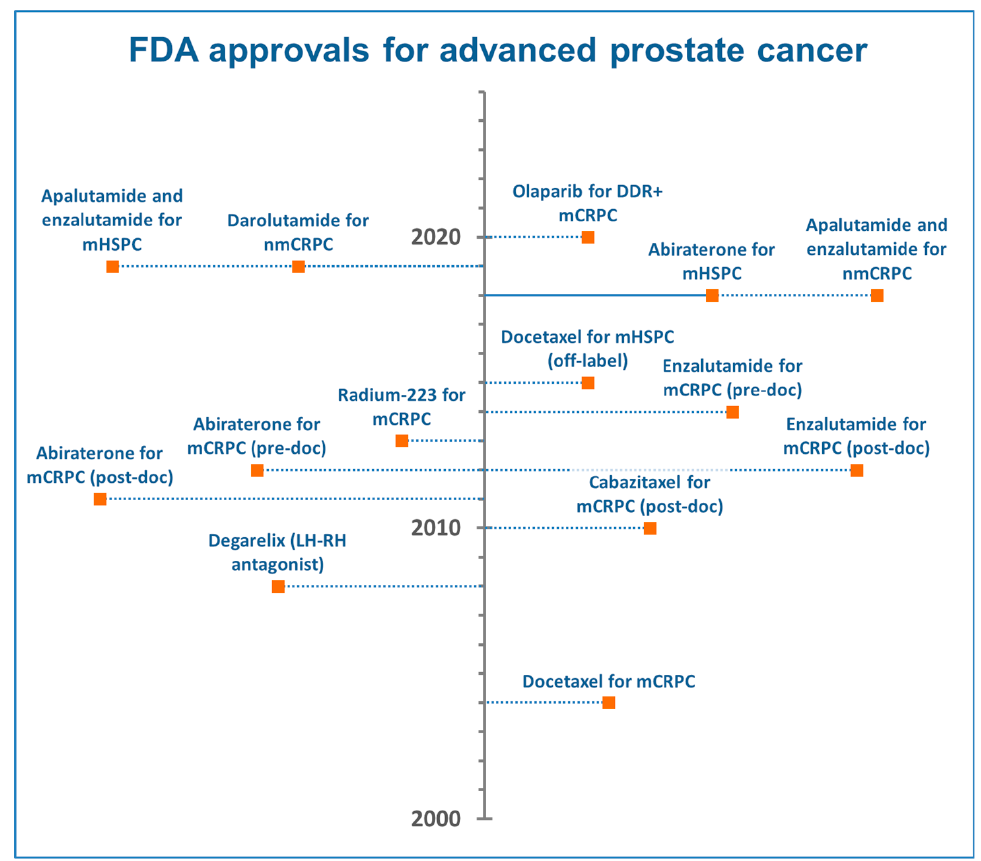
Figure 1. Regulatory timeline of approvals in advanced prostate cancer therapies. DDR+: DNA damage response genes mutated; mHSPC: metastatic hormone-sensitive prostate cancer; mCRPC: metastatic castration-resistant prostate cancer; nmCRPC: nonmetastatic castration-resistant prostate cancer; post-doc: post-docetaxel; pre-doc: